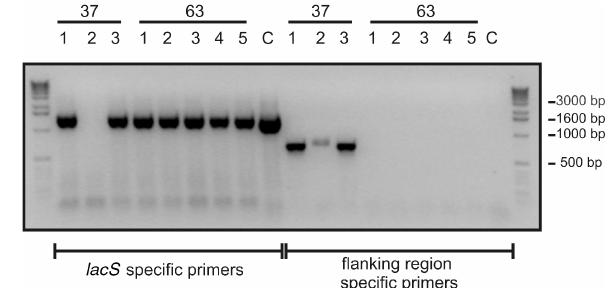
Figure 3. Analysis of genomic DNA of individual cultures obtained from selected blue colonies from cells electroporated with either pSVA37 or pSVA6. The left panel shows the presence of the marker gene using lacS specific primers. The right panel shows the positive identification of successful integrations using primers specific for an internal part of lacS and the 5 ′ flanking region of the targeted Sso0120 gene. As a positive control (C) for the lacS PCR Solfolobus solfa- taricus P2 genomic DNA was used, while for the PCR of the flanking region, genomic DNA of PBL2025 was used as a negative control. The DNA marker sizes are indicated.